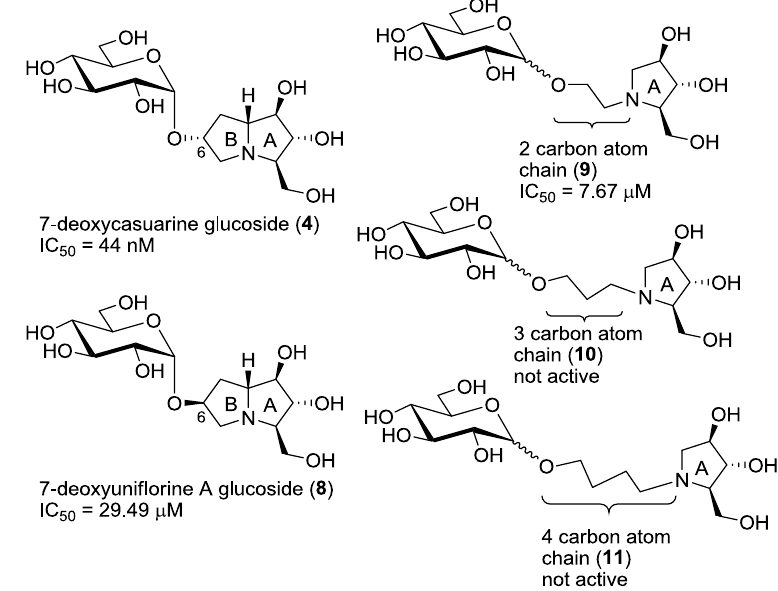
Figure 3. Compounds 4 , 8 , 9 , 10 , 11 and their IC 50 values towards C. riparius trehalase.